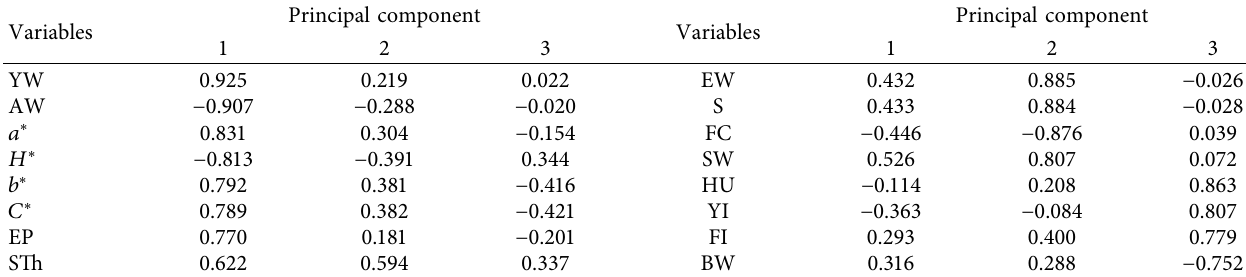
Table 7: Tree main components explain more than 85% of the total information on zootechnical performance, physical egg quality, and yolk color measurement during the experimental